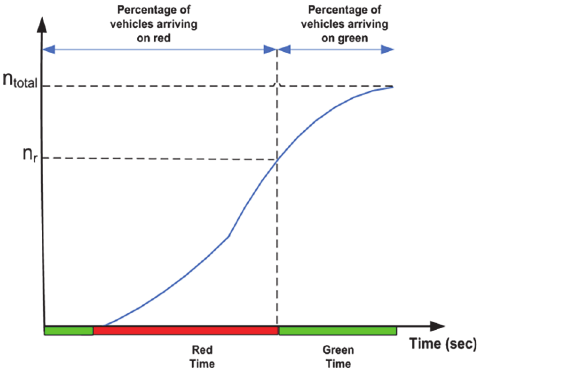
Fig 10. Progression